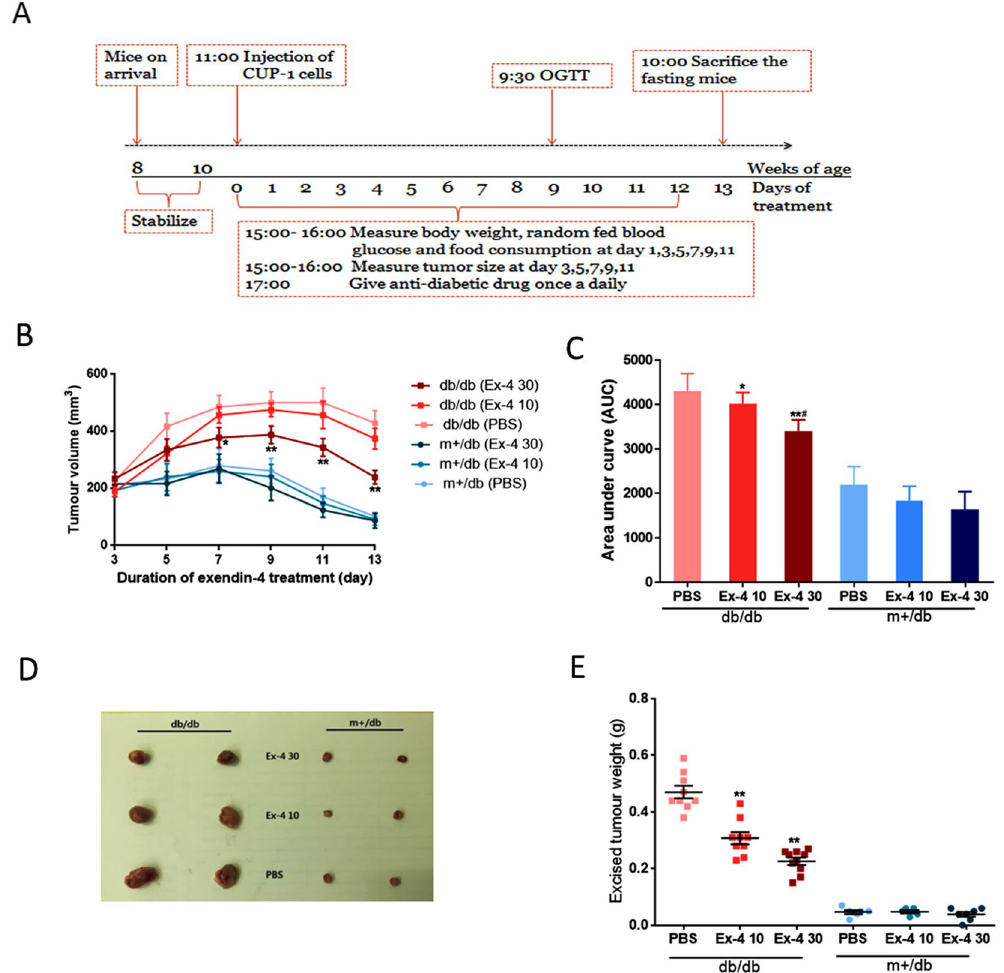
Figure 2. Effects of exendin-4 on tumor growth in db/db and db/m + mice. ( A ) Experimental timeline of 13- day exendin-4 treatment in CUP-1 syngeneic db/db and db/m + mice. Male db/db and db/m + mice inoculated with 2 × 10 7 CUP-1 cells were treated with exendin-4 intraperitoneally (10 or 30 nM/kg body weight) for 13 days (n = 10 per group). Tumors were measured every other day in the db/db and db/m + mice ( B and C ). Mice were sacrificed and tumors were excised after 13 days of exendin-4 treatment. Mean excised tumor weight were compared between groups ( D and E ). Ex-4 30 and Ex-4 10: exendin-4 treatment at 30 and 10 nM/kg body weight. * p < 0.05, ** p < 0.01, compared with PBS-treated group in the corresponding db/db or db/m +